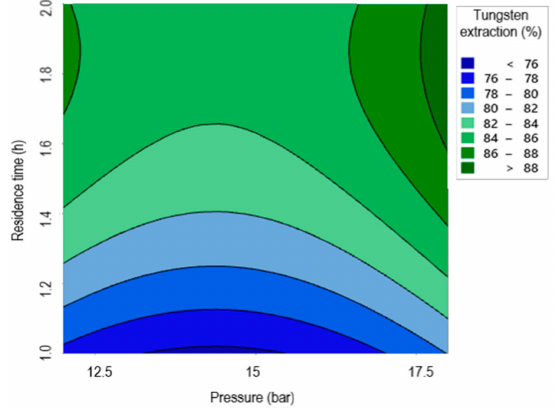
Figure 7. Variable pressure and residence time of tungsten-extraction